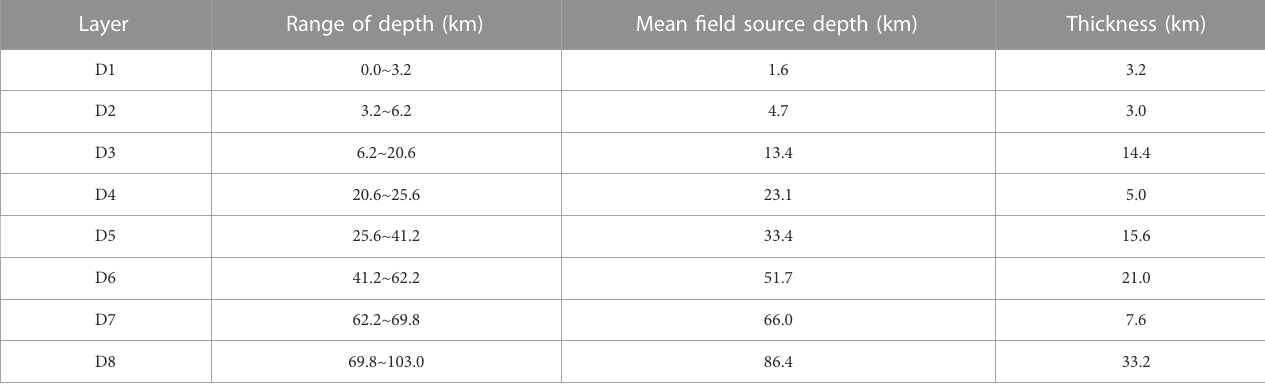
TABLE 1 The layered model in the mare